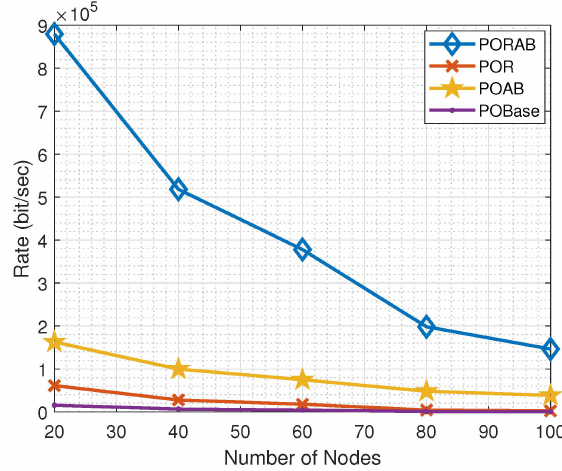
Figure 5. Variation of transmission rate with the number of nodes.